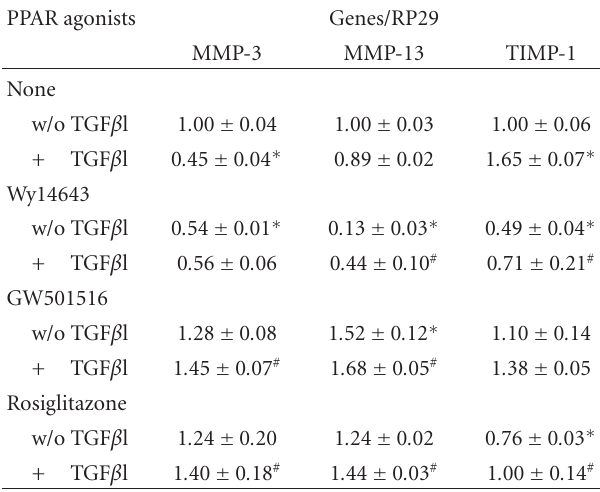
Table 2: E ff ects of selective PPAR agonists on TGF- β 1-induced changes in MMPs and TIMP-1 genes expression in rat chondro- cytes. Chondrocytes, embedded in alginate beads (5 . 10 4 cells per bead), were exposed to Wy14643 (100 μ M), GW501516 (100nM), or rosiglitazone (10 μ M) for 2h before stimulation with TGF- β 1 (10 ng/mL), in the presence or absence of PPAR agonists, for 48h. Normalized mRNA levels of MMP-3, MMP-13, and TIMP-1 quantified by real-time PCR ( n = 4). Data are expressed as mean ± SEM. Statistically significant di ff erences from the control